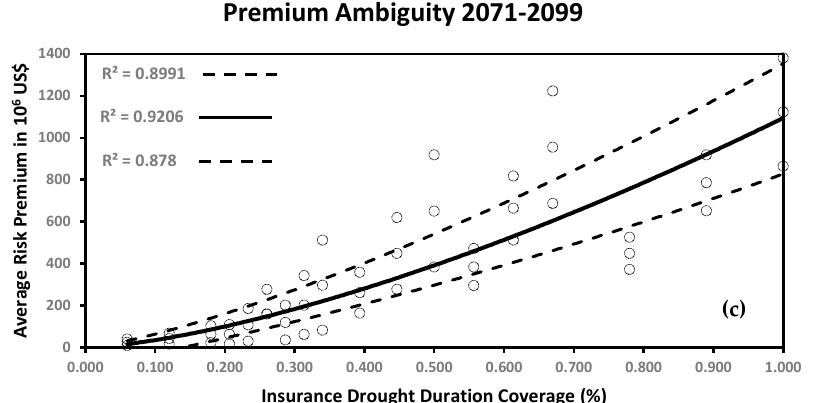
Figure 7. Average insurance premium ambiguity vs. drought duration coverage: ( a ) 2007–2040, ( b )